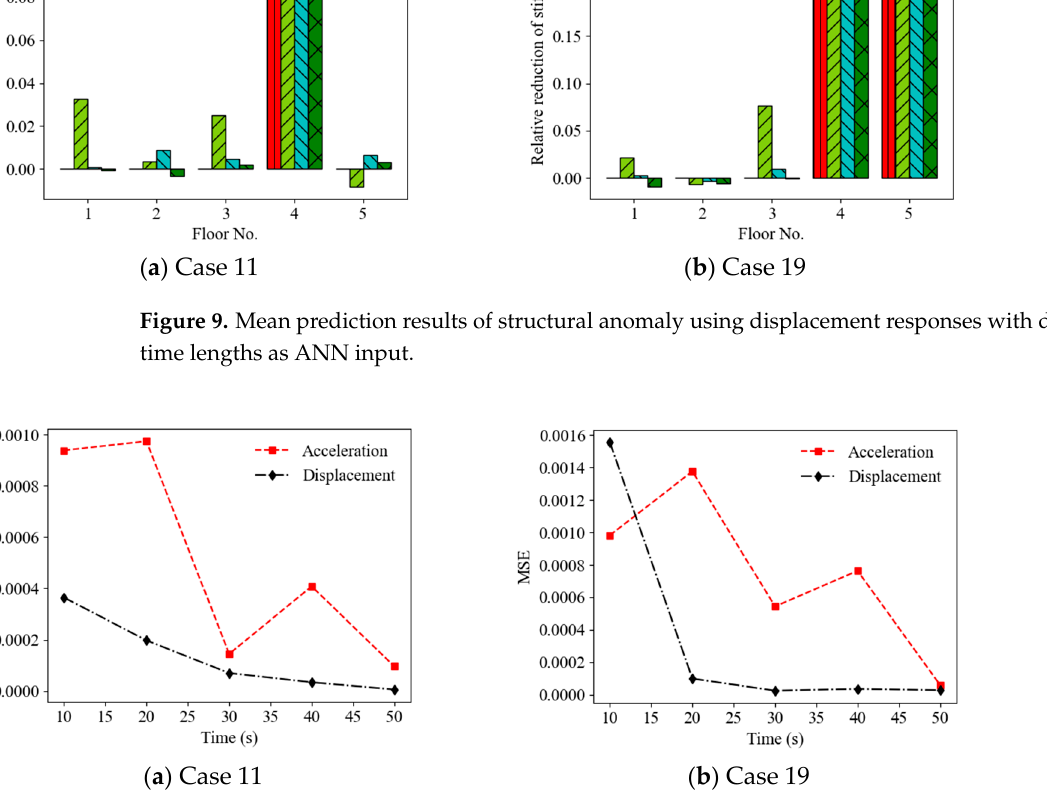
Figure 10. MSEs of prediction values versus time length using acceleration and displacement responses as ANN input.